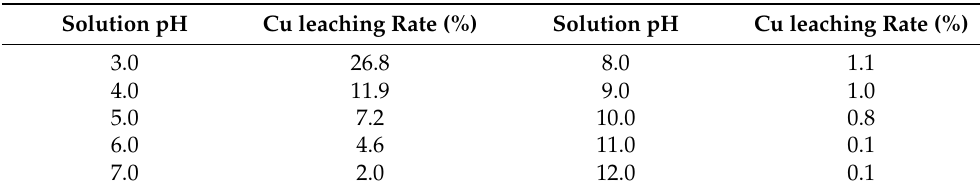
Figure 4. Effect of the solution pH on ( a ) iodide anion and ( b ) iodate anion removal rates by Cu 2 O, AES biochar, and C ‐ Cu. ( c ) Effect of the solution pH on iodide ion and iodate ion adsorption onto C ‐ Cu. C 0 = 10 mg/L, adsorbent dosage 0.5 g/L, 25 °C. ( d ) Zeta potentials of Cu 2 O, AES biochar, and C ‐ Cu. Table 5. Cu leaching rates (%) in solutions with different pH values.